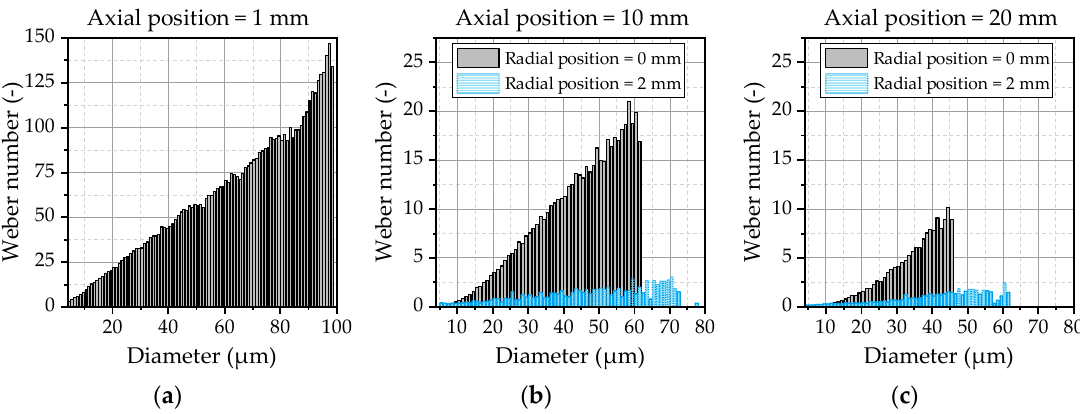
Figure 14. Droplet Weber number as function of the droplet diameter for OP 2 in the vicinity of the nozzle ( a ) 10 mm ( b ) and 20 mm ( c ) downstream of the nozzle exit.